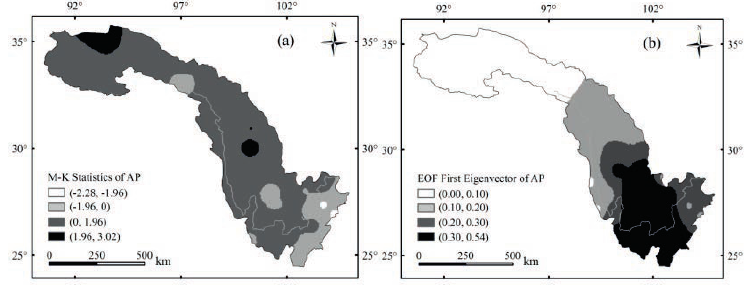
Fig. 3 Spatial changes of AP during 1961–2010 in the Jinsha River basin: (a) M-K statistics (b)